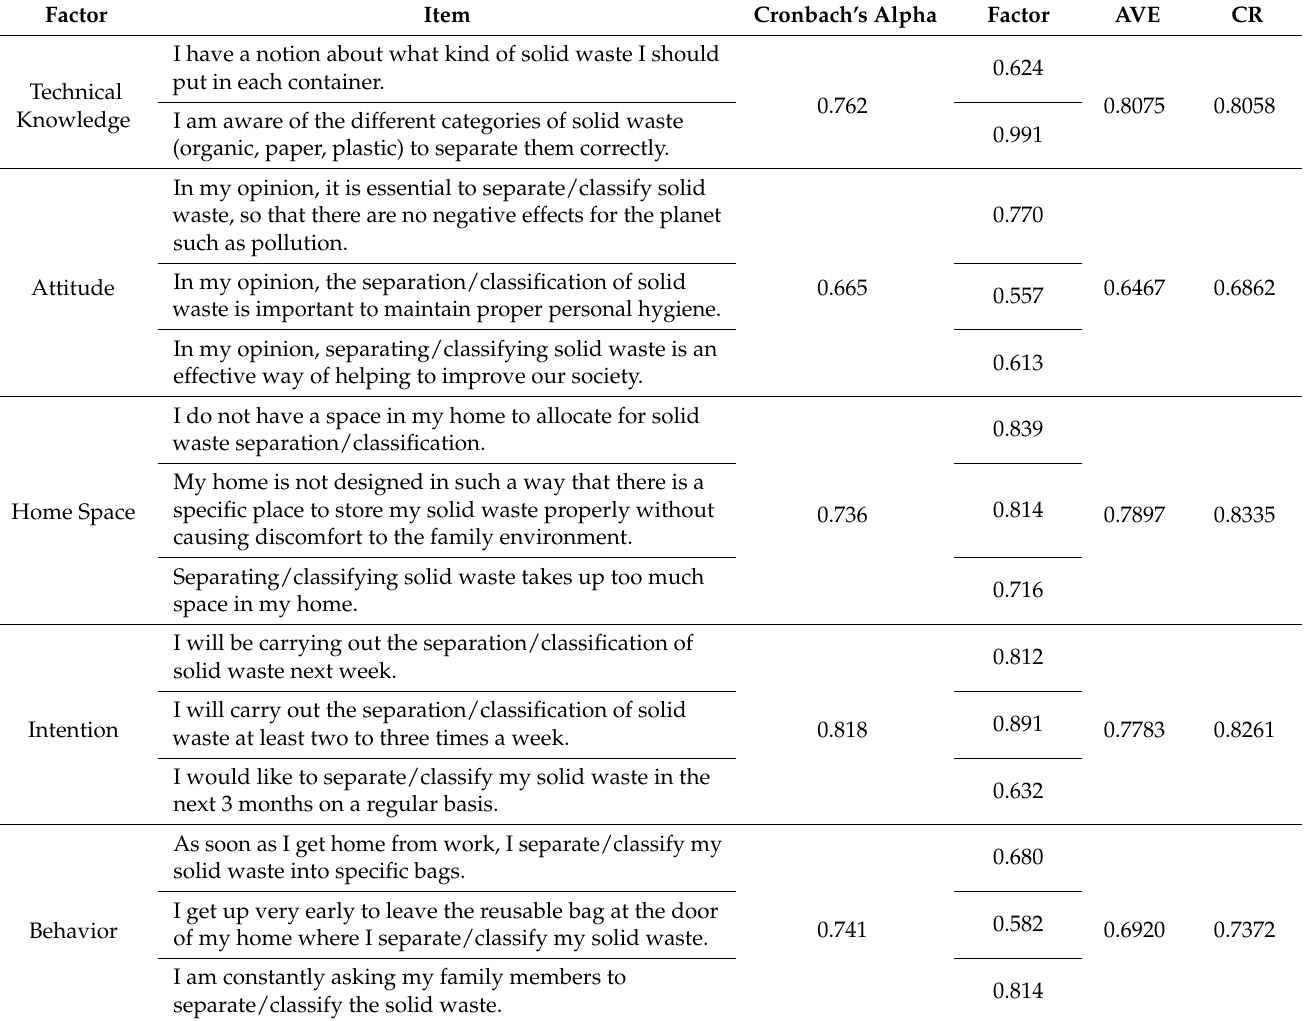
Table 3. Internal validation